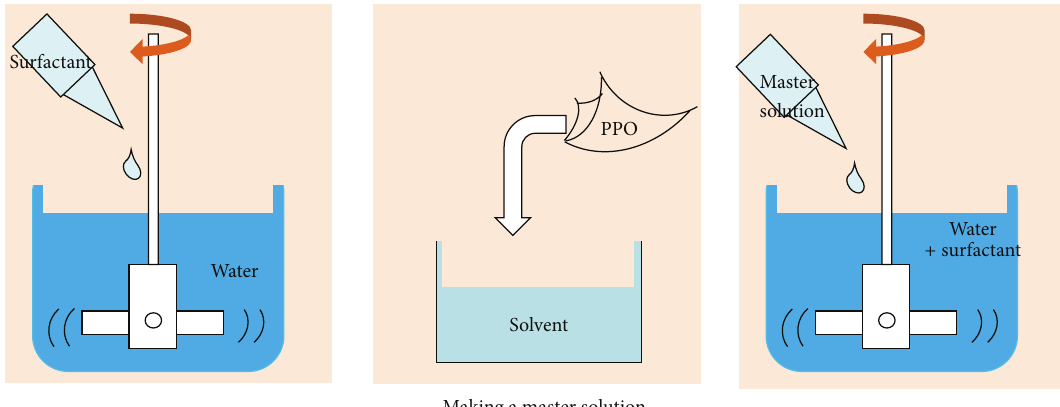
Figure 2: Synthesis process of WbLS (S1 sample). Surfactant is added to water. PPO is dissolved in organic solvent. Finally master solution is mixed with solution of water and surfactant with a proper speed of impeller.